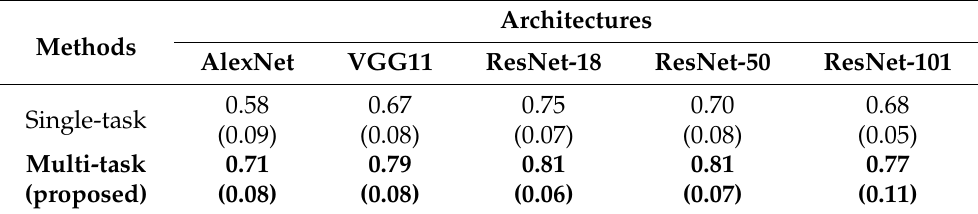
Table 5. Comparisons of results using single-task models and multi-task models, in terms of exact match ratios. The best values for each architecture are in bold. The mean exact match ratio and standard deviations (in parentheses) are reported.